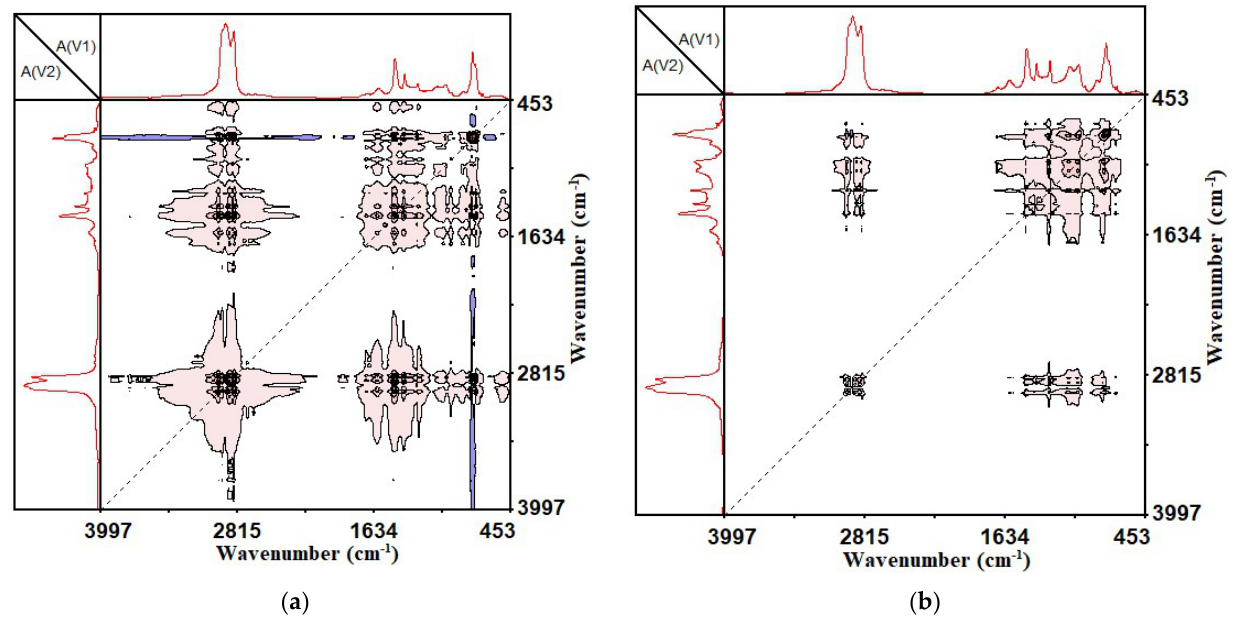
Figure 8. Two-dimensional synchronous infrared correlation spectrum of 4000~450 cm −1 . ( a ) SBS-modified asphalt binder; ( b ) SBS + 1% CNTs composite-modified asphalt binder.